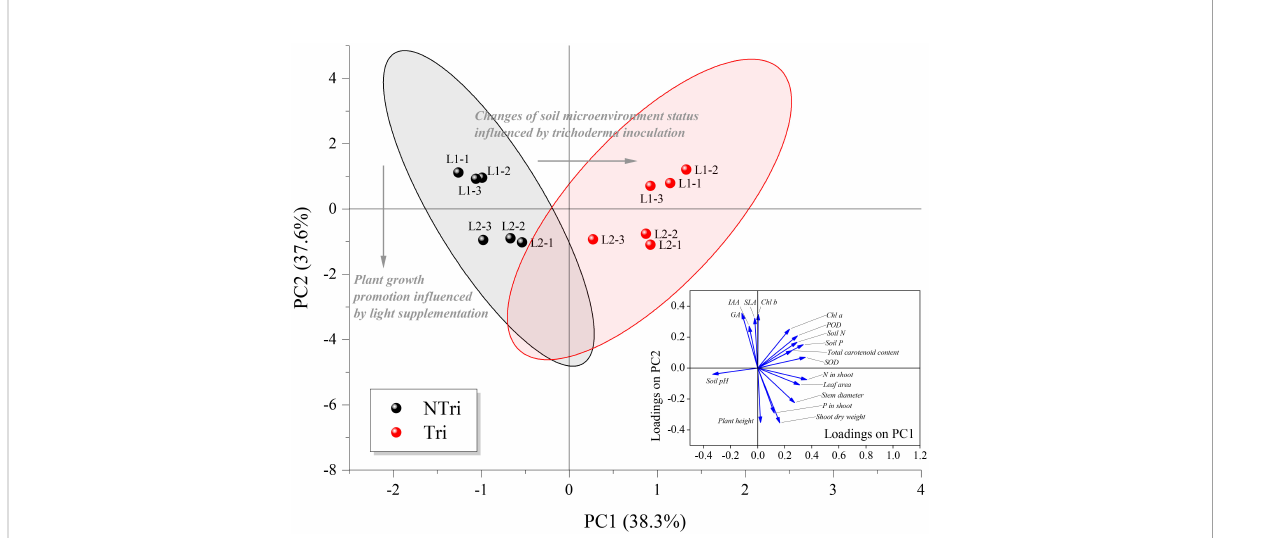
FIGURE 4 Biplot of principal component analysis (PCA) for the factors. NTri and Tri denote the Non- Trichoderma inoculated and Trichoderma inoculated groups, respectively. L1 and L2 denote the treatment groups with the light intensity of 50 and 150 m mol·m -2 ·s -1 , respectively. Blue arrows denote the loadings, which are the coef fi cients of the linear combination of the factors that constitute the PCs. The gray arrows denote the principal in fl uencing processes characterized by the sample scatter distribution. Samples of each treatment group are clustered and enveloped in their respective 95% con fi dence